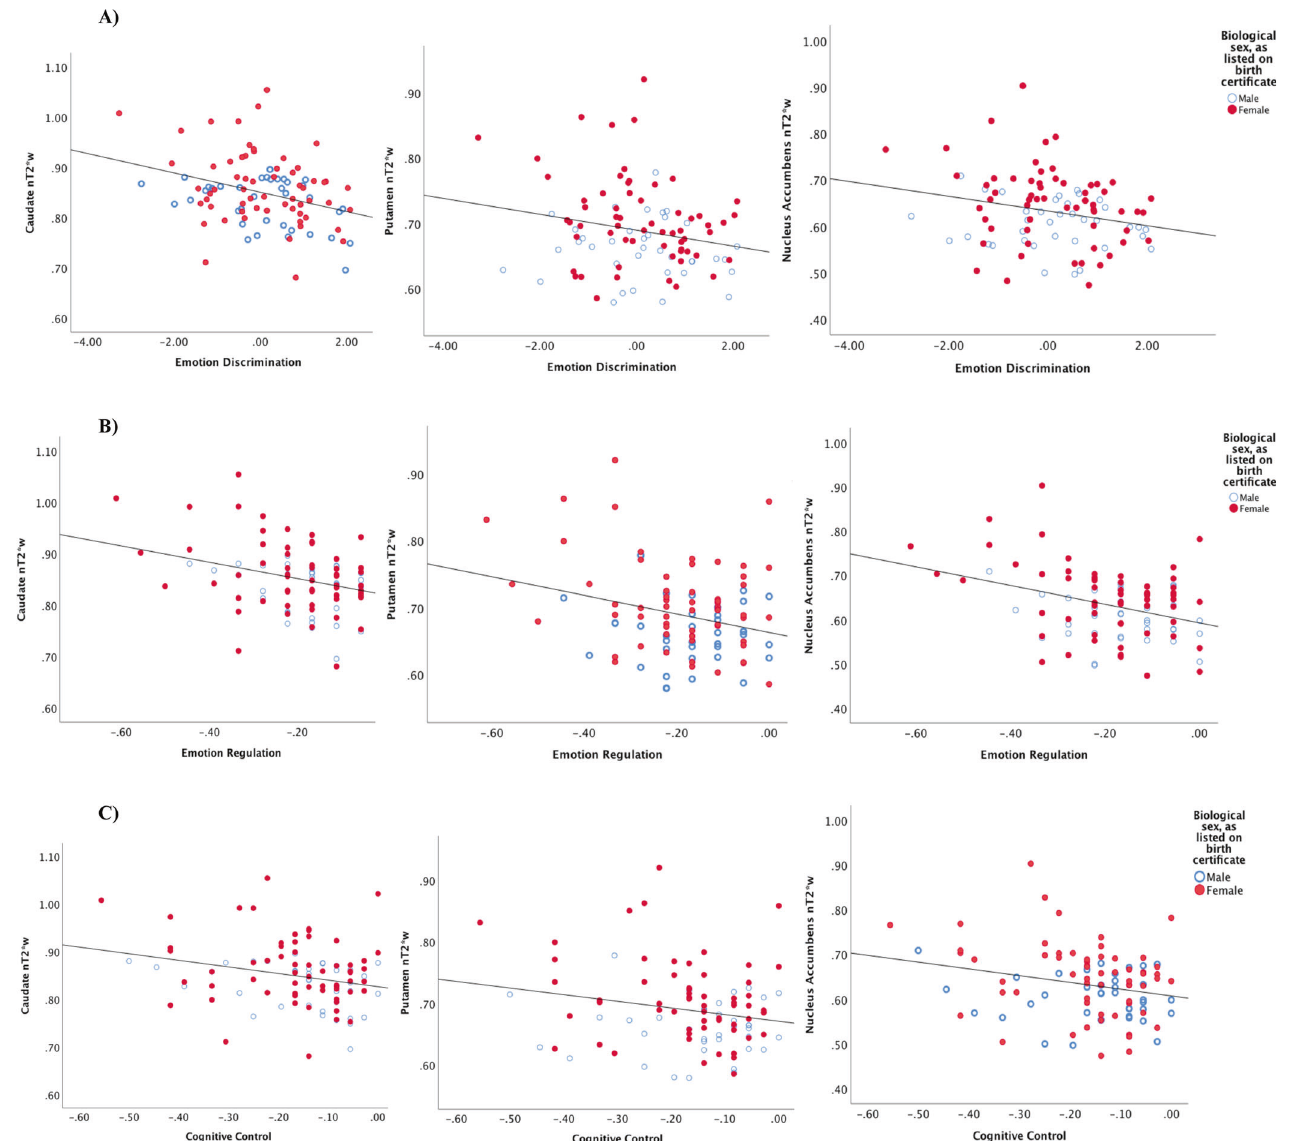
Fig. 2 Scatterplots depicting the nature of correlational relationships between striatal normalized T2*-weighted (nT2*w) signal and Go- NoGo performance-based indices across patients, as reported in Table 2. For nT2*w signal, higher values indicate lower tissue iron concentration; for task indices, higher values indicate better performance. Sex differences in nT2*w are simultaneously illustrated through individual points for female (red, fi lled) and male (blue, hollow) participants. Scatterplots depict nT2*w correlational relationships with performance-based indices of A emotion discrimination; B emotion regulation; and C cognitive